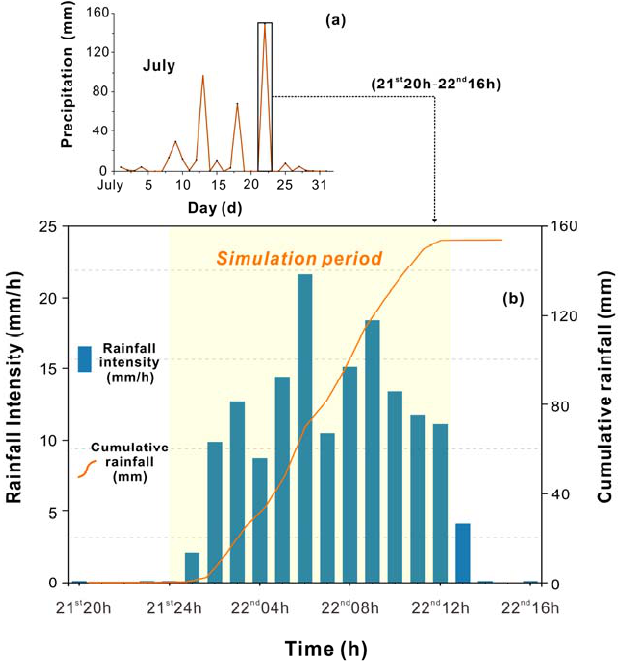
Figure 4. ( a ) Daily precipitation information for July 2013. ( b ) Hourly rainfall intensity and cumulative rainfall for the heavy rainfall that caused the landslides in July 2013.